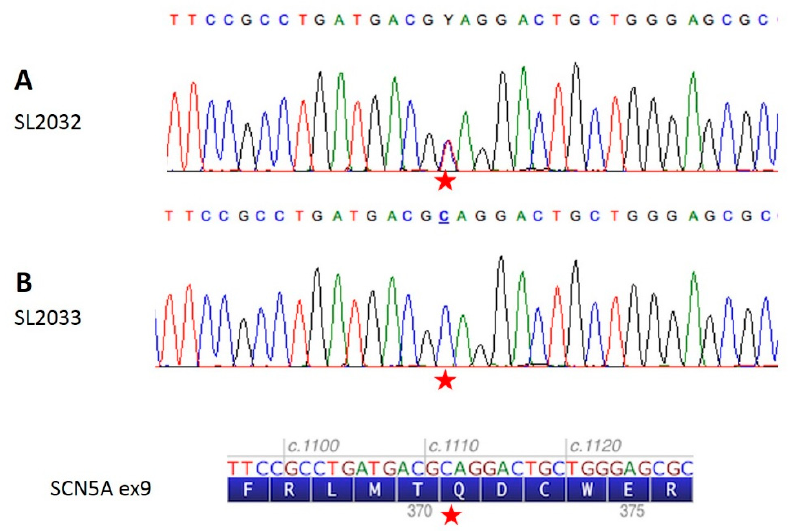
Figure 1. Identification of the c.1111C>T (p.Gln371*) heterozygous nonsense mutation in the SCN5A gene by Sanger sequencing. The red star indicates the location of the mutation ( A ) Sample SL2032 (II-4) (proband) harboring the familial variant in heterozygosis (in accordance with IUPAC nomenclature, “Y” is used as the ambiguous code to describe the simultaneous presence of both the wild type C and mutant T peaks). ( B ) Sample SL2033 (II-5) resulted negative for the mutation.